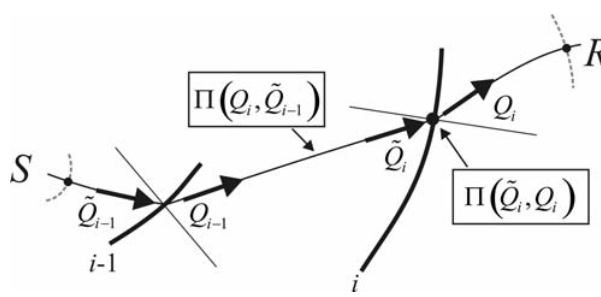
Figure 3. Ray propagator in a layered medium (Equation 3.1). Geometrical spreading is related to the ratio of the wavefront curvature (gray dashed lines) at the receiver (R) and source